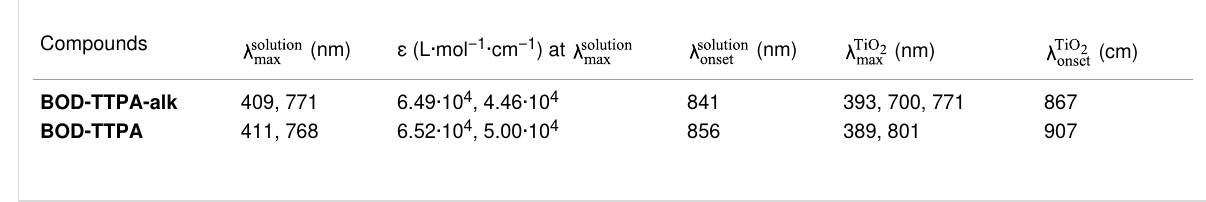
Table 1: Selected optical properties of compounds BOD-TTPA - alk and BOD-TTPA .